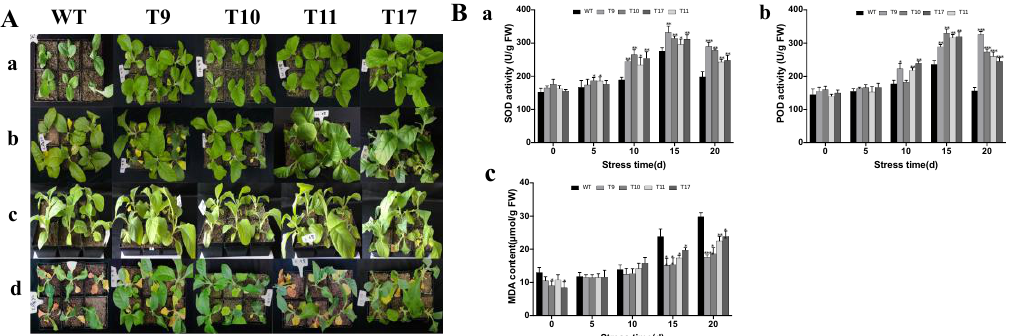
Figure 7. ( A ). Performance of transgenic (TG) and wild-type (WT) control plants under drought stress. (a): 0 d, top view; (b,c): 10 d after water withholding, top view and side view; (d): 20 d after water withholding, top view. ( B ). Physiological parameters associated with plant stress response measured at various time points after drought stress. (a) Effect of the drought stress on plant SOD activity. (b) Effect of the drought stress on plant POD activity. (c) Effect of drought stress on plant MDA content. Each column represents the mean of three biological replicates. Error bars represent SE. A significant difference between WT and each TG line at p < 0.05, 0.01 or 0.001 by the Student’s t- test was represented as “*”, “**” or “***”, respectively.